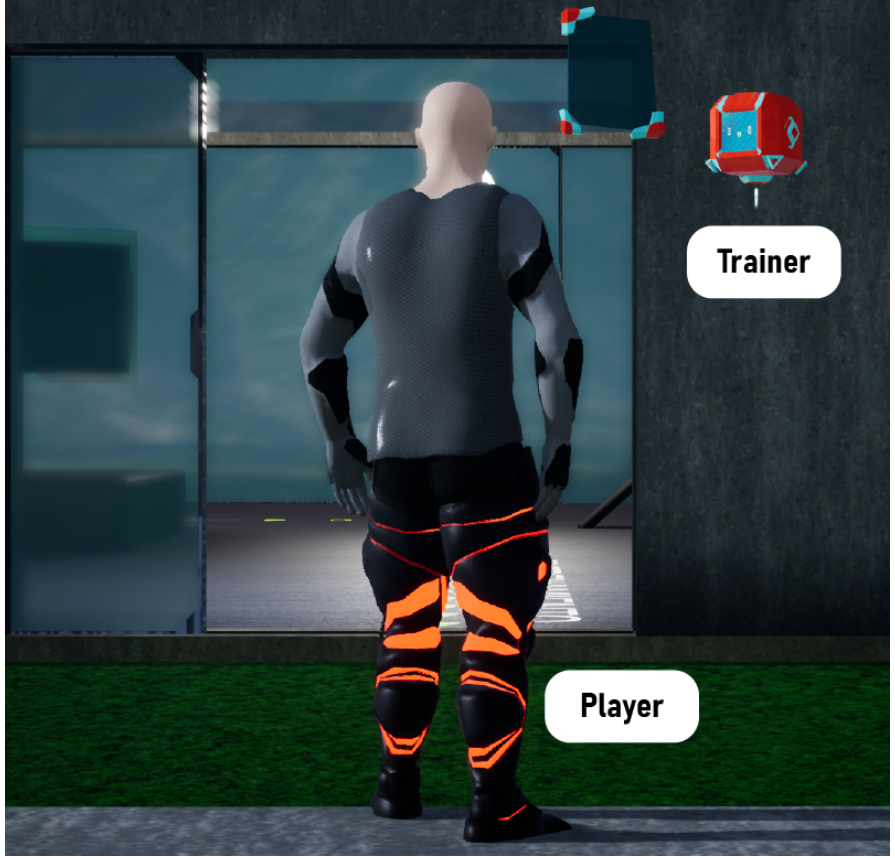
Figure 5. Avatar and trainer in Exogames